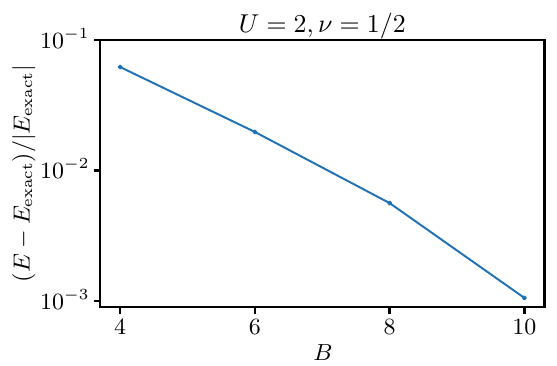
FIG. 4. Scaling of the GMPS+U method when changing block size B —variational energy of GMPS+U ansatz for the Fermi- Hubbard chain at half-filling with U = 2 converges rapidly (approximately exponentially over the range of parameters explored) with block size B , which suggests that this method can be used to achieve the arbitrary desired